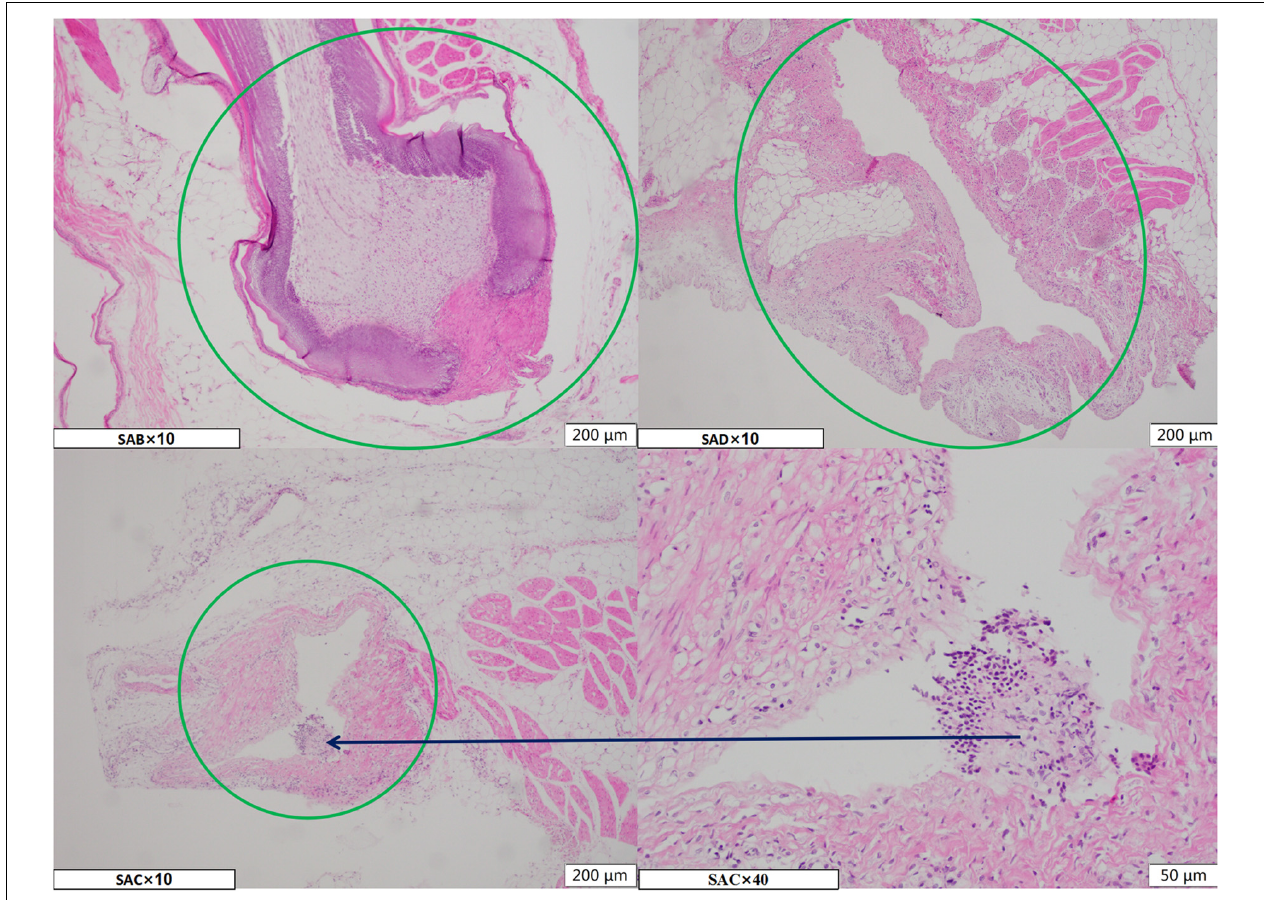
FIGURE 1 | The microscope image of the HE staining paraffin section of the chicken breast skin during three processing stages. SAB, SAD, and SAC group indicate, respectively, samples of skin with feather follicles after bleeding, defeathering, and chilling processes. The green circle marks the area of the feather follicle, and the black arrows represent local magnification of the corresponding